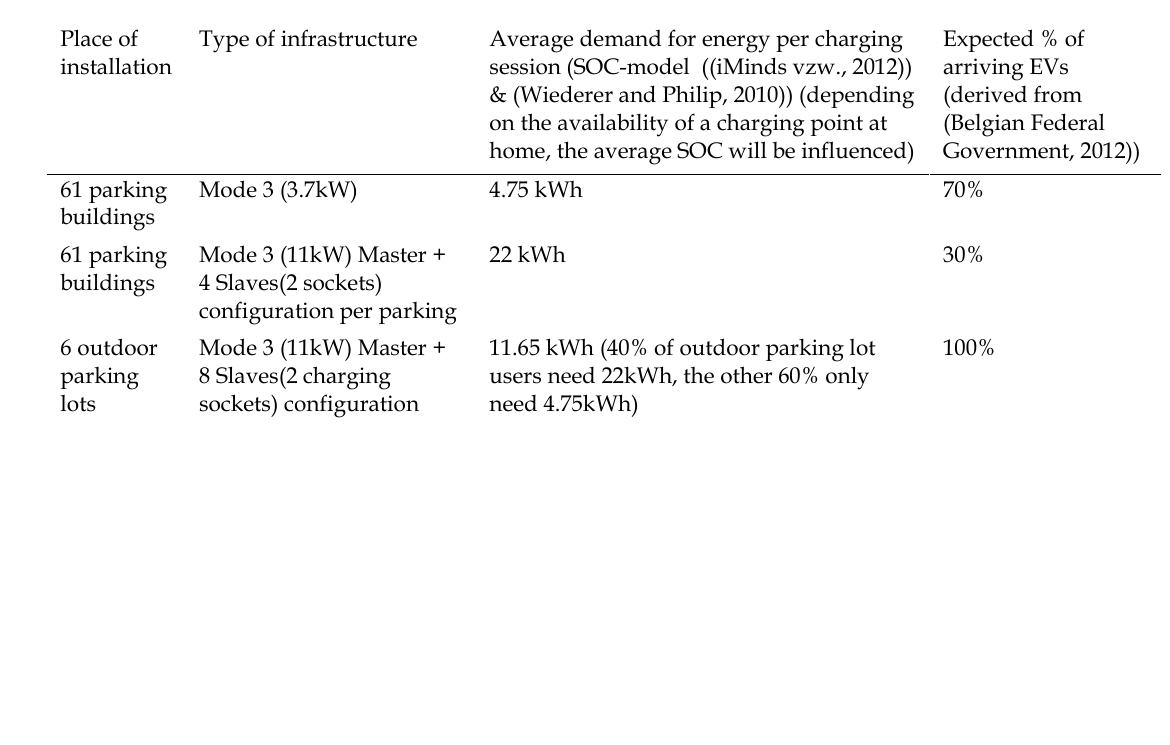
Figure 8. Evolution of the number of charging poles accumulated over all parking areas (scen. C) The average expected electrical demand per arriving EV is based on the SOC-model and parking availability analysis per type of house in Belgium (Belgian Federal Government, 2012) (approximately 70% of all residents have the access to a private parking spot). People who can charge at home will have a lower average demand for energy than people who cannot charge their vehicle at home. The latter people will not have the capability to charge their vehicle at home during the night and will have therefore a higher demand for external energy. Table 4 gives an overview of the desired installation. In this model, the initial charging fee is set at 32c€/kWh. This means a mark-up of 13c€/kWh is added on top of the average consumer price for electricity (incl. grid access and transport costs) (Commissie voor de Regulering van de Elektriciteit en het Gas (CREG), 2013). According to (Kley et al., 2010) and (Wiederer and Philip, 2010) realistic mark-ups range from 0.01 to 0.20€/kWh. Type of charging infrastructure a.f.o. place of